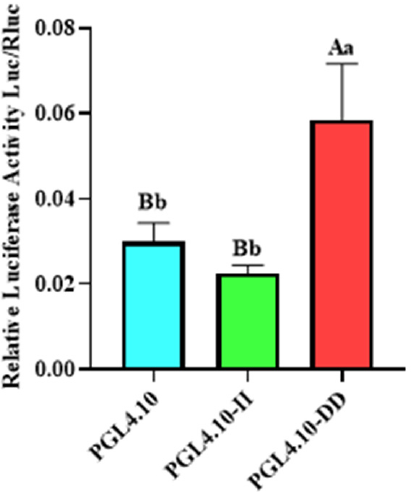
Figure 2. The dual-luciferase activity of GHR-SV246 mutant recombinant plasmid in 293T cells; the same letter means no significant difference ( p > 0.05); different letters indicate significant differences ( p < 0.05). 3.5. Effect of Transcription Factors on the Transcriptional Activity of Mutant Recombinant Plasmids In order to determine the effect of Runx1 transcription-factor binding with the 246 bp deletion on transcriptional activity in cells, the pGL4.10-KO-Runx1 luciferase reporter vector with mutant Runx1 binding site was constructed, and its fluorescence activity was identified. The luciferase activity of vector pGL4.10-KO-Runx1 was significantly lower than that of vector pGL4.10-II (Figure 3; p < 0.05), indicating that the transcription factor Runx1 could be combined with the II genotype sequence, thus increasing its transcriptional activity in cells.